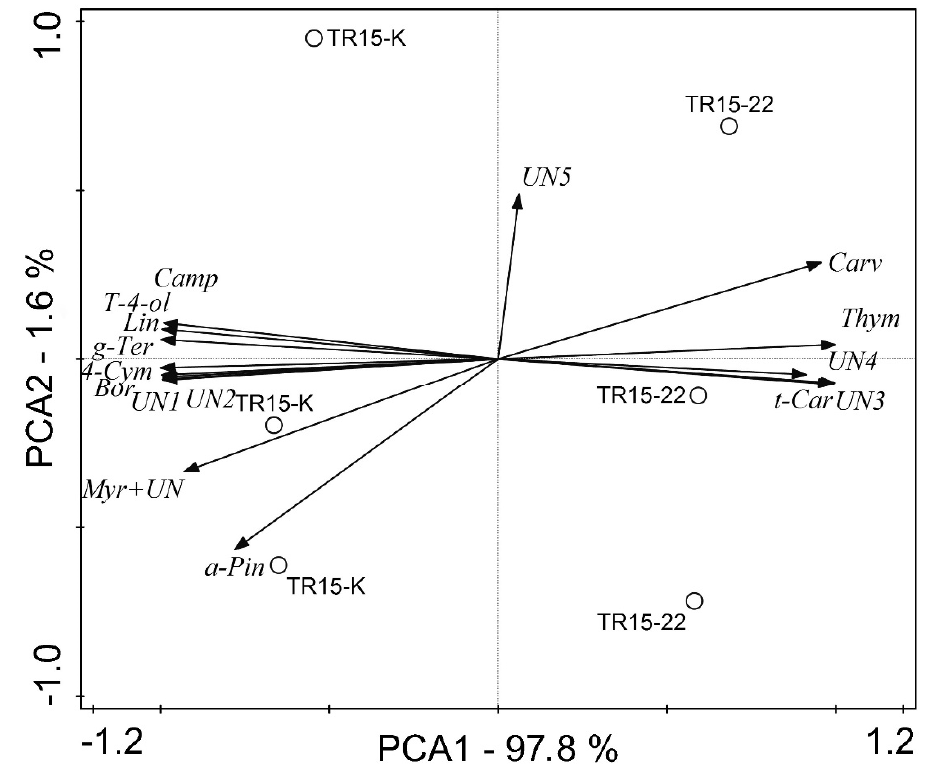
Figure 4. Principal component analysis (PCA) on relative abundances of individual terpenes in essential oil from tetraploid subclone (TR15-22) and the diploid reference subclone (TR15-K). Bor, borneol; Camp, camphor; Carv, carvacrol; α -Pin, a-pinene; t -Car, trans -caryophyllene; 4 -Cym, 4 -cymene; Lin, linalool; Myr + UN, myrcene + UN; γ -Ter, g-terpinene; T-4-ol, terpinen-4-ol; Thym, thymol; UN1-5, unknown compound 1-5.